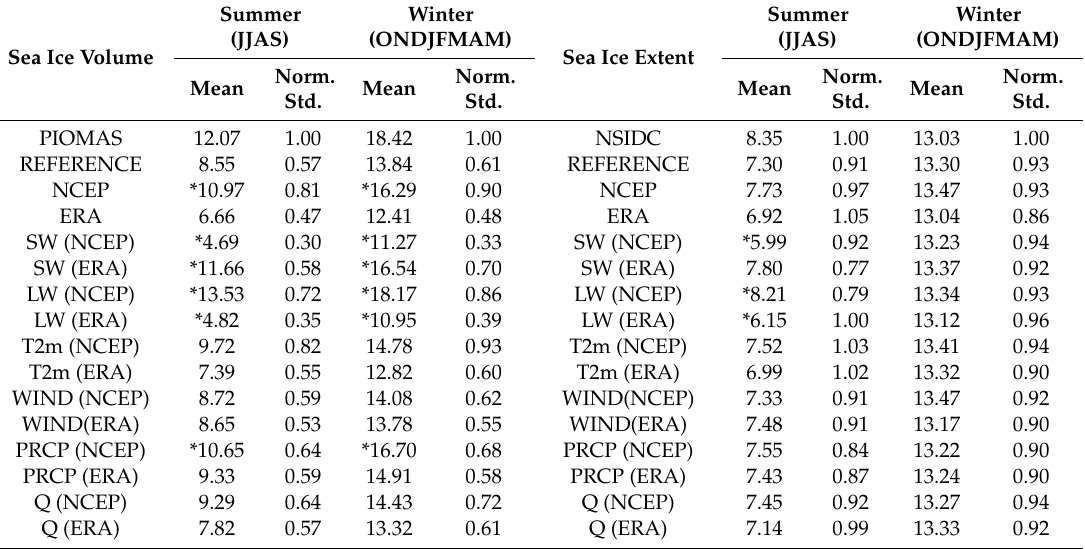
Table 3. Mean and normalized standard deviations of summer (JJAS) and winter (ONDJFMAM) sea ice volume and sea ice extent.